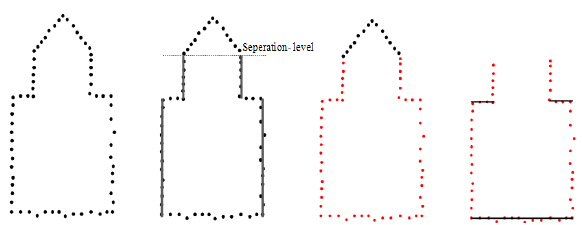
Figure 3: Geometric fitting: (a) boundary points; (b) extracted vertical line segments; (c) separated into two parts; and (d) extracted horizontal line segments By analysing the proximity between end points of each line segment, the line-adjacency list is created to get sequentially ordered line segments. With help of the line adjacency, geometry (a polyline) of the lower part is generated. Orthogonality between neighbouring lines is searched during the model fitting. Accordingly, new lines are inserted to form a complete model.